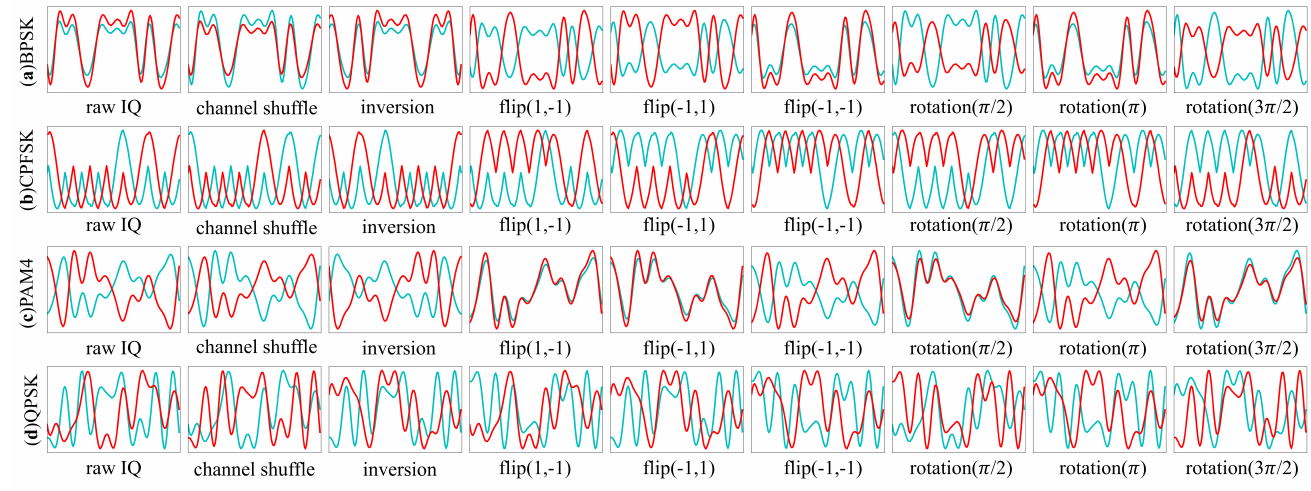
Figure 5. ( a ) BPSK, ( b ) CPFSK, ( c ) PAM4, and ( d ) QPSK samples from 2016A with SNR = 18 dB and various data augmentation methods. Where flip( α , β ) represents the flip of the IQ components. That is, − 1 means switching the I or Q component value to its opposite, and 1 means remaining unchanged. The cyan line shows the in-phase component while the red line shows the quadrature